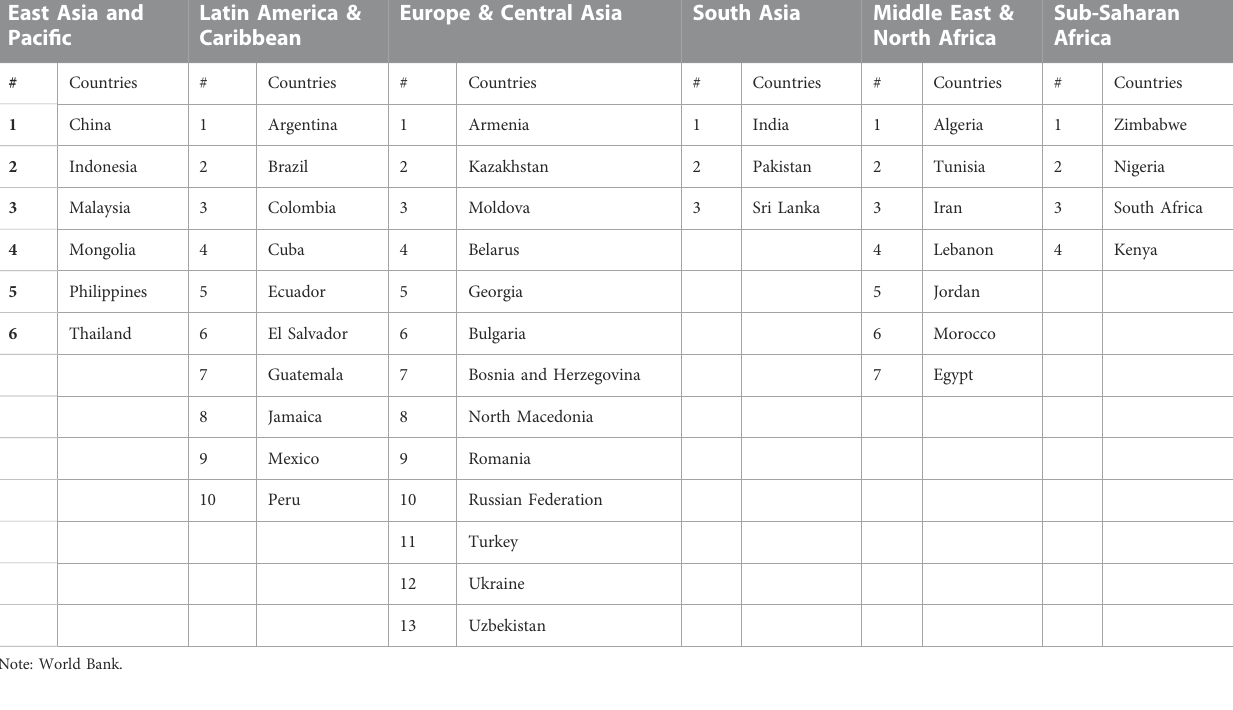
TABLE 3 Description of variables.